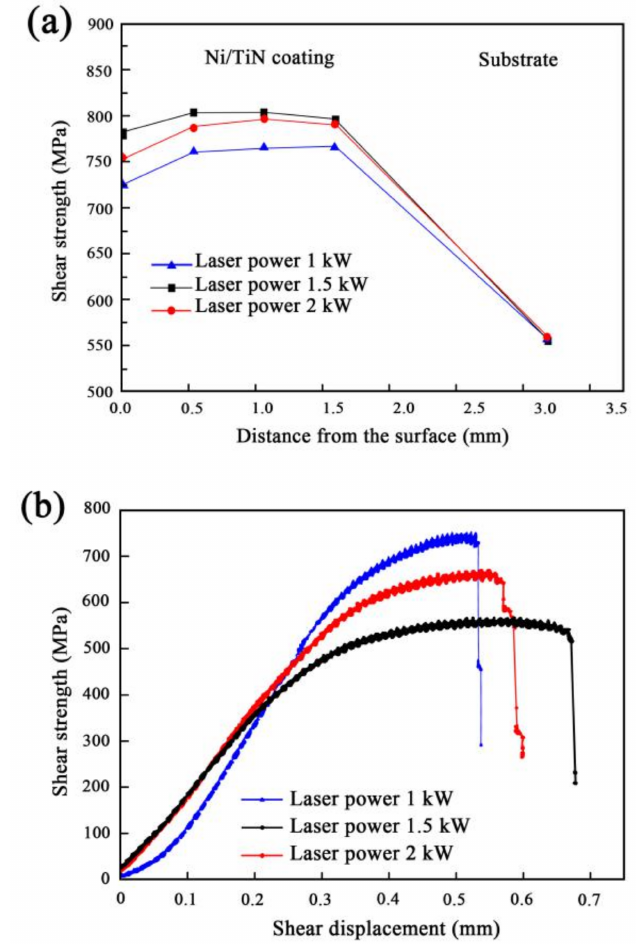
Figure 6. Shear strength curves ( a ) and shear displacement curves ( b ) of Ni/TiN coatings produced at various laser